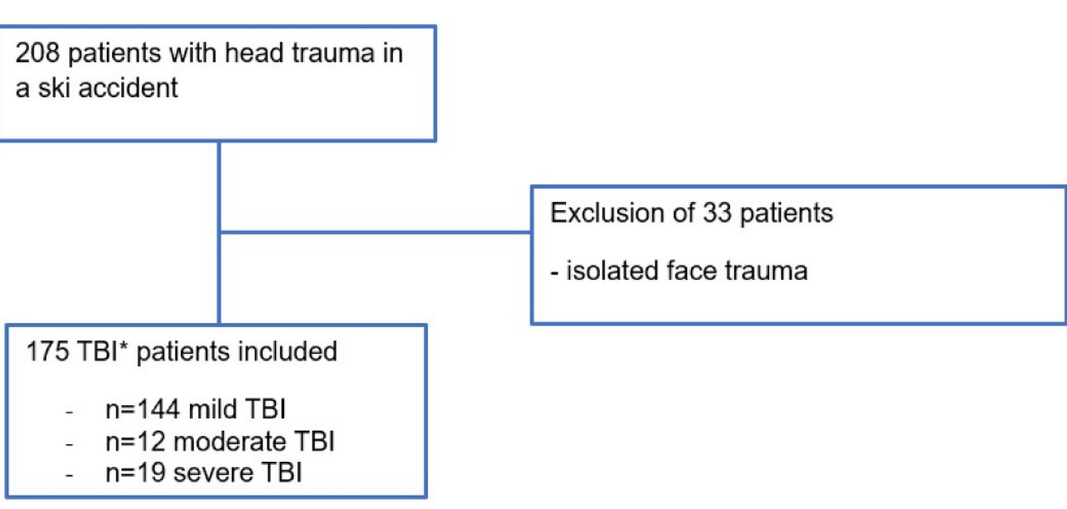
Fig 1. Flow chart of patient inclusion and exclusion. � TBI = Traumatic Brain